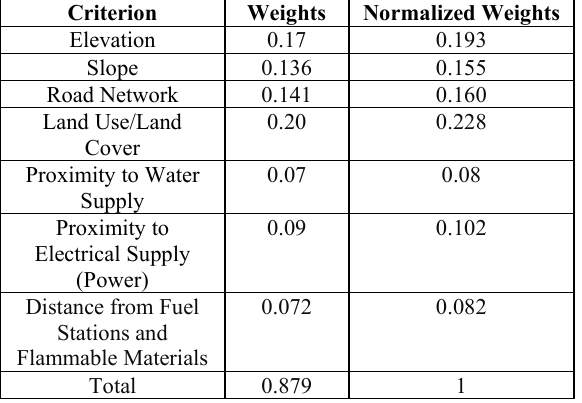
Table 2 . Criteria and Weights